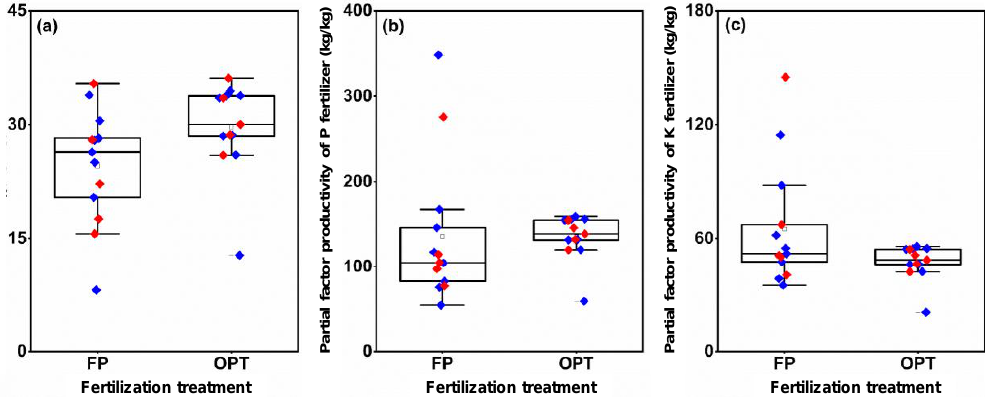
Figure 6. Partial factor productivity of N ( a ), P ( b ), and K fertilizer ( c ) under different fertilization treatments. FP: farmers’ practice fertilization; OPT: optimized fertilization. For each boxplot, the top, middle, and bottom solid lines of the box represent the 75% quantile, 50% quantile, and 25% quantile, respectively; the top and bottom horizontal lines outside the box represent the 90% quantile, and 10% quantile, respectively. The square inside the box represents the mean. Blue or red diamonds: data in 2020 or 2021.